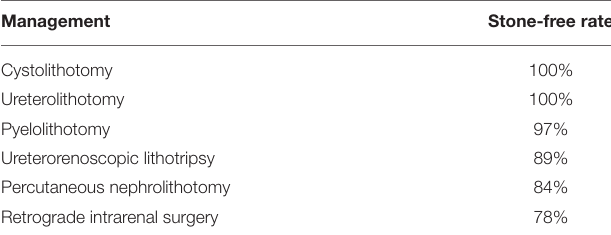
TABLE 2 | Stone-free rates following minimally invasive and open surgical